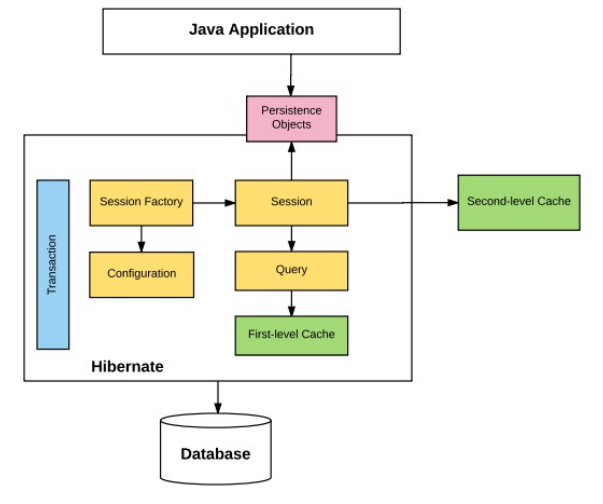
Fig. 3 Hibernate frame